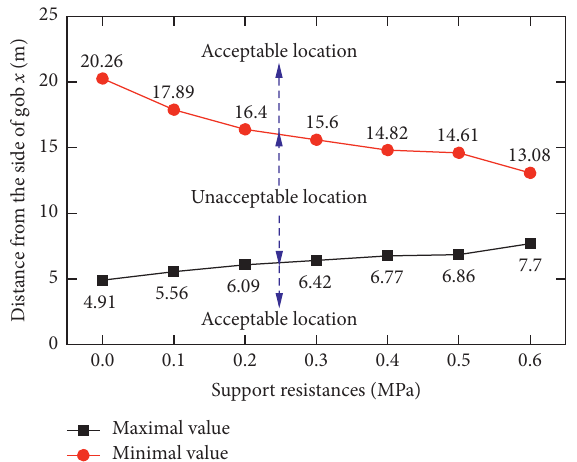
Figure 14: Effects of the support resistance on entry layout with ELAD.